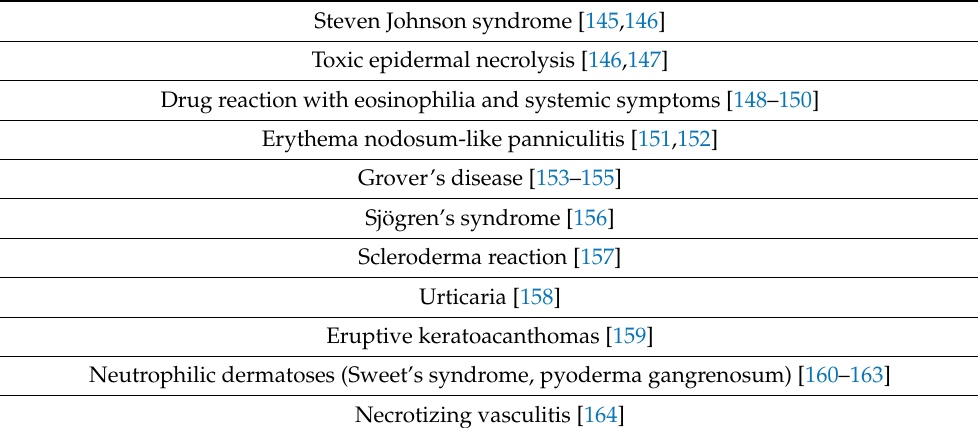
Table 4. Rare cutaneous immune-related adverse events